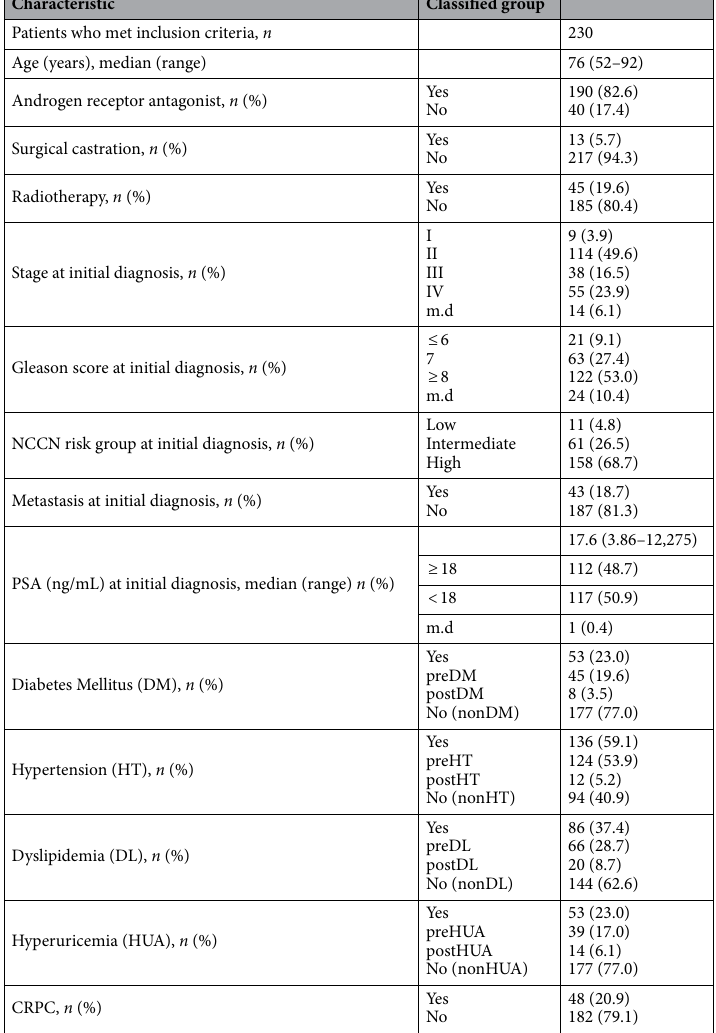
Table 1. Characteristics of prostate cancer patients undergoing hormone therapy. m.d . missing data. Lifestyle- related diseases were separated into preexisting ones before hormone therapy (preDM, preHT, preDL and preHUA) and newly developed ones after the onset of hormone therapy (postDM, postHT, postDL and postHUA), and compared to cases without such diseases (nonDM, nonHT, nonDL and